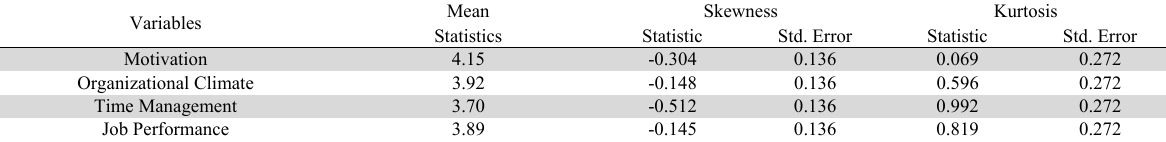
The Results of Descriptive Statistics